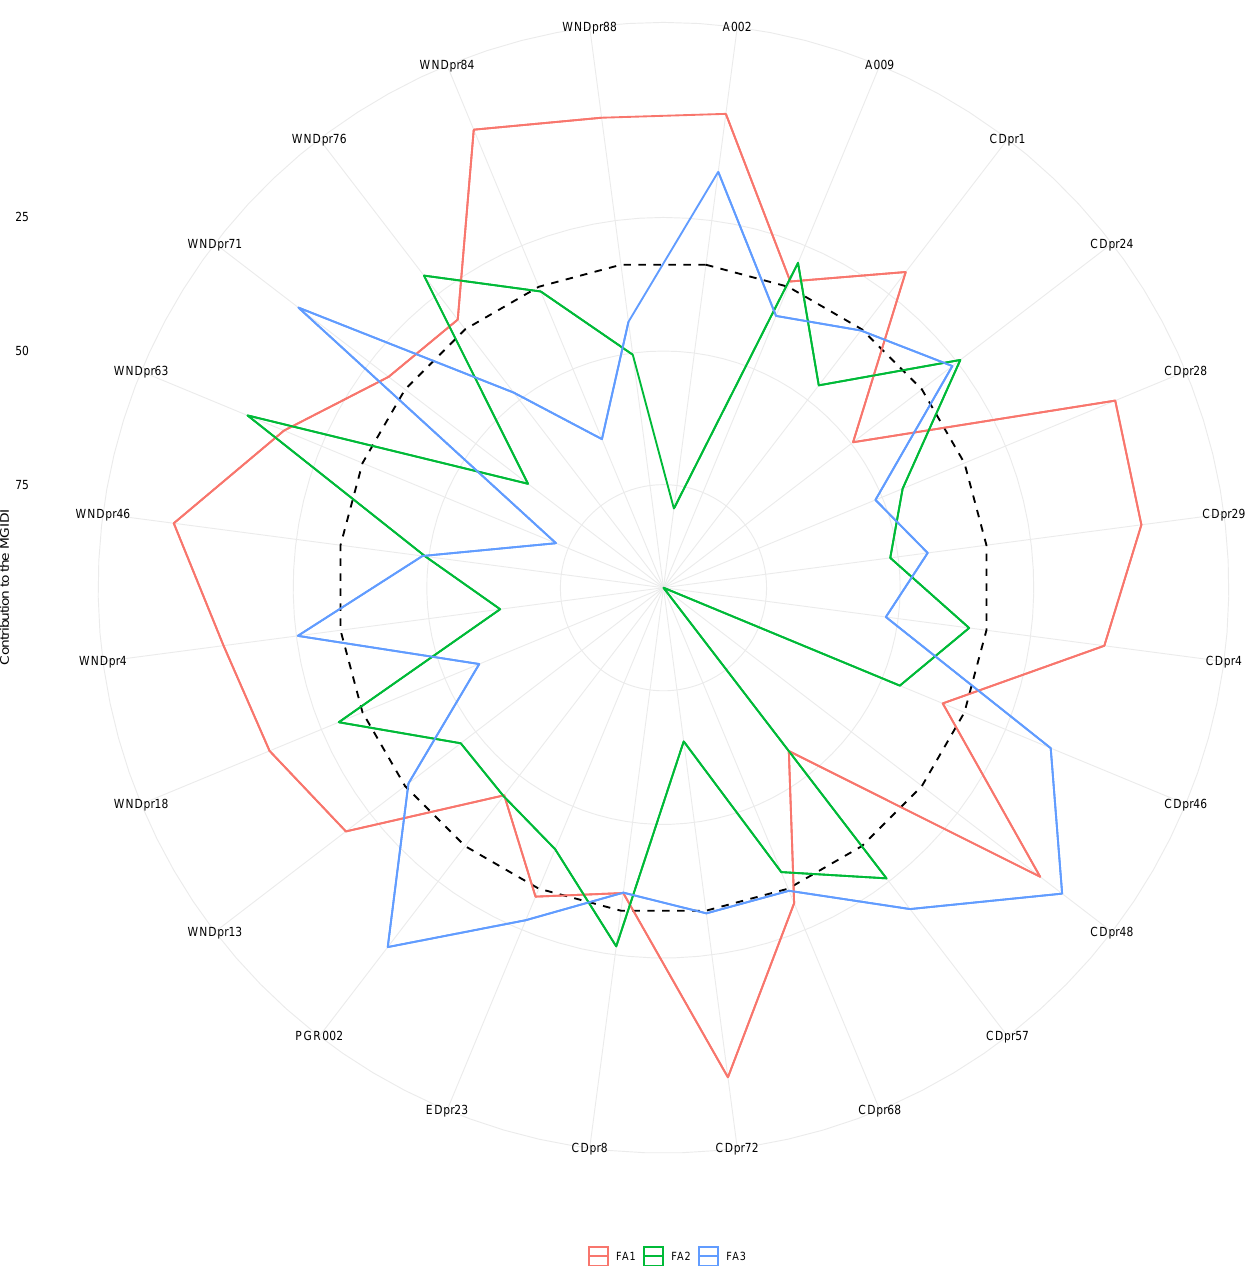
Figure 6. The strengths and weaknesses of the selected genotypes are shown as the proportion of each factor on the computed multi-trait genotype–ideotype index (MGIDI). The smaller the proportion explained by a factor (closer to the external edge), the closer the traits within that factor are to the ideotype. The black broken circle at the center shows the theoretical value if all the factors contributed equally. A002: Asamankese002; A009: